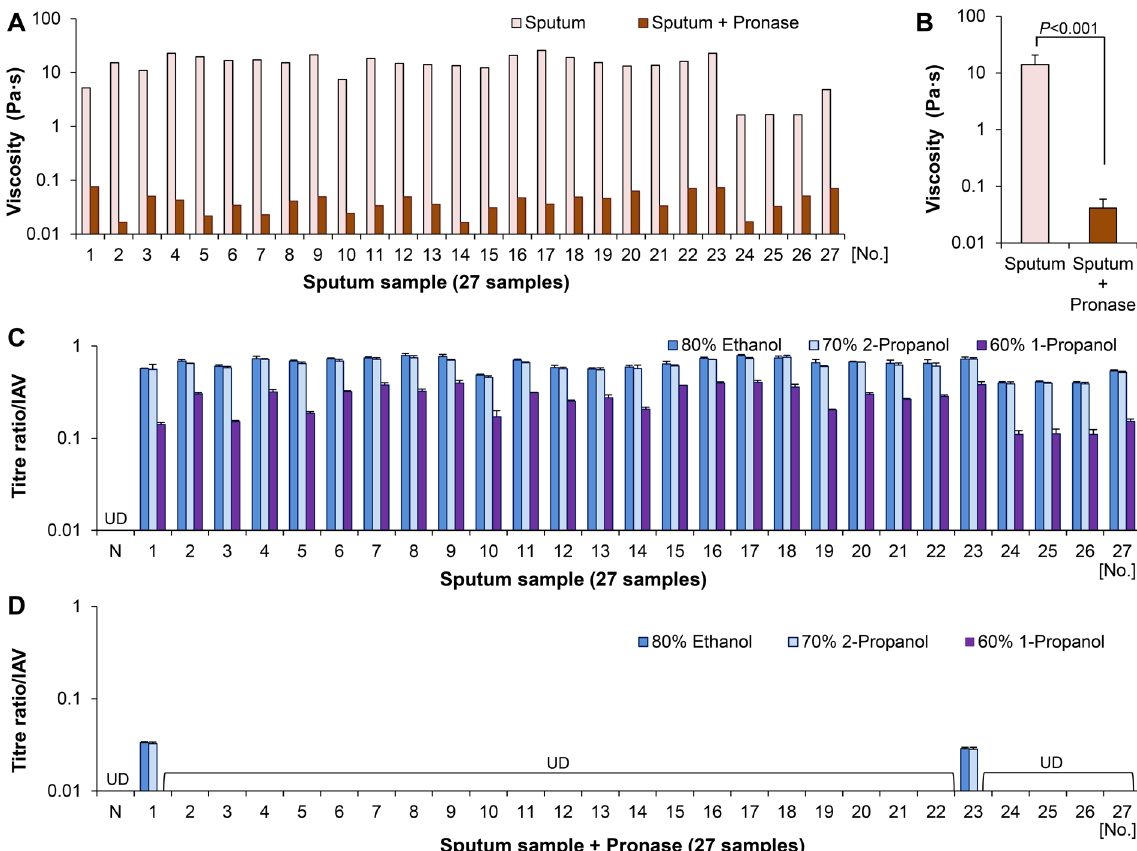
Figure 4. Viscosity analysis and inactivation test using sputum samples with or without pronase treatment. The inactivation test and viscosity analysis were carried out using sputum samples with or without pronase treatment and artificial mucus to determine whether pathogens are protected from alcohol-based disinfectants. ( A ) Viscosity of 27 sputum samples (with or without pronase treatment). ( B ) Comparison of sputum sample viscosity with and without pronase treatment. ( C ) Inactivation test using the 27 sputum samples to evaluate resistance to alcohol-based disinfectants. ( D ) Inactivation test using 27 sputum samples treated with pronase. N, negative control (alcohol-based disinfectants added to virus in saline); UD, undetectable. Data are expressed as the mean ± SD based on at least three independent